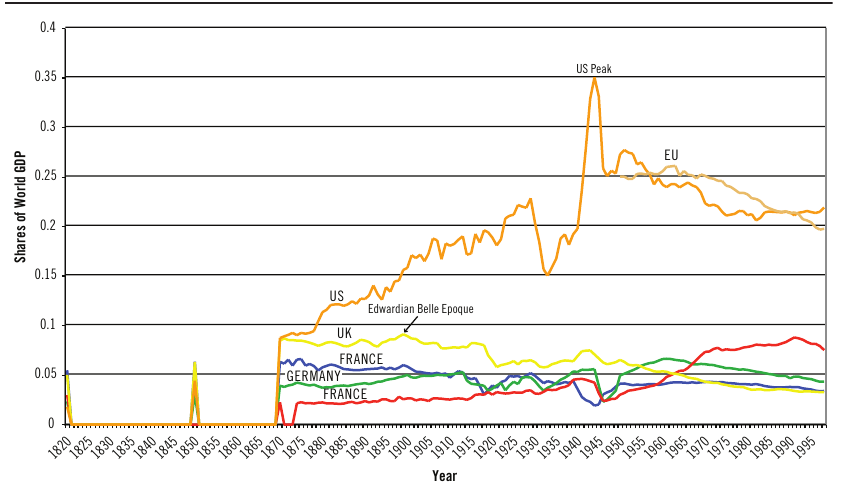
Figure 3 – Declining U.S. Economic Hegemony Figure 4 – International Trade Relative to the Size of the Global